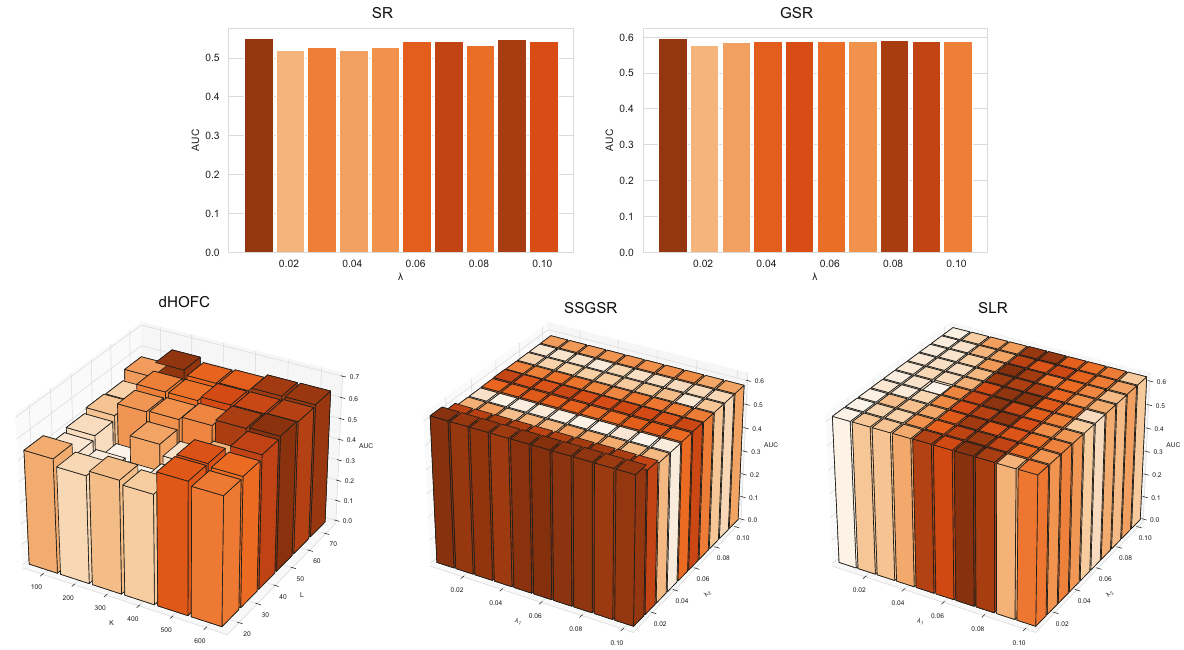
Fig. 3 AUC changing with different parameter combinations. Results of SR and GSR with a single parameter are shown in the 2-D bar plot, while dHOFC, SSGSR, and SLR with two parameters are shown in the 3-D bar